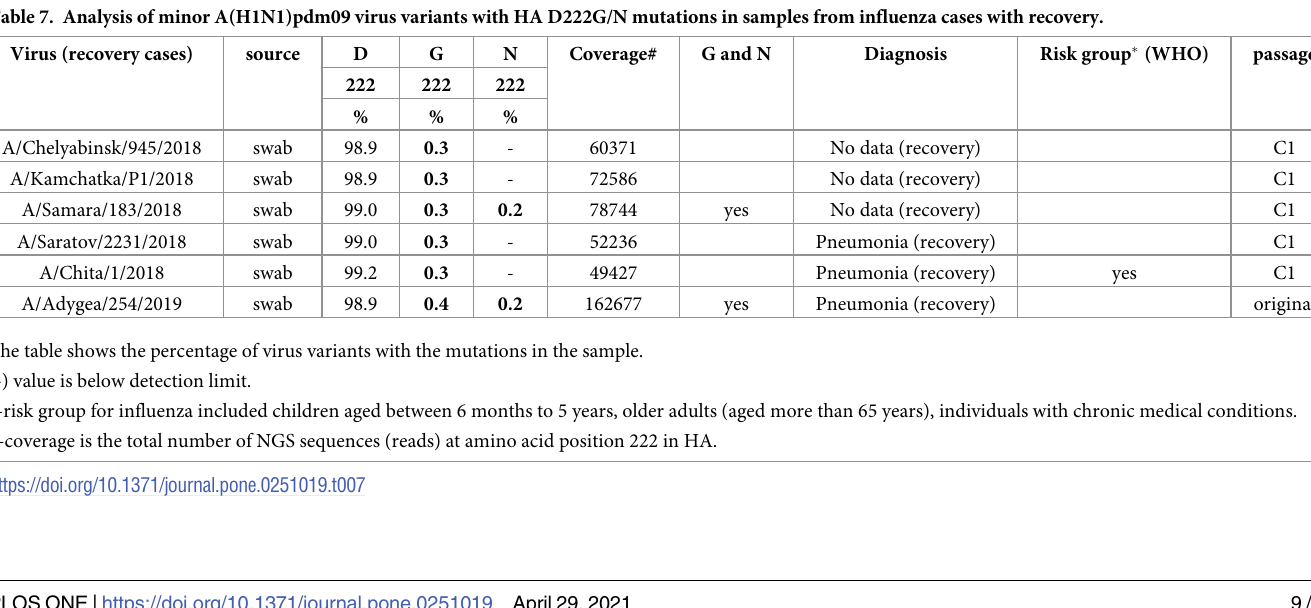
Analysis of the average percentage of nucleotide substitutions in the genome of the A(H1N1) pdm09 was conducted using available NGS data and control plasmid samples. For A(H1N1) pdm2009 virus samples with sequence coverage of more than 20,000 reads, the highest average percentage of substitutions was observed for the pair A to G and T to C, which amounted to 0.33% and 0.32% substitutions/nucleotide respectively, for the HA1 gene segment. The next most frequent was the pair C to T and G to A at 0.14% and 0.12%, respectively, while the per- centage of mutations in the control plasmid was 0.05–0.07% for these two pairs (S1 Table). A higher percentage of the mutations A to G and T to C was observed in HA1 compared to HA2 and in all other gene segments.